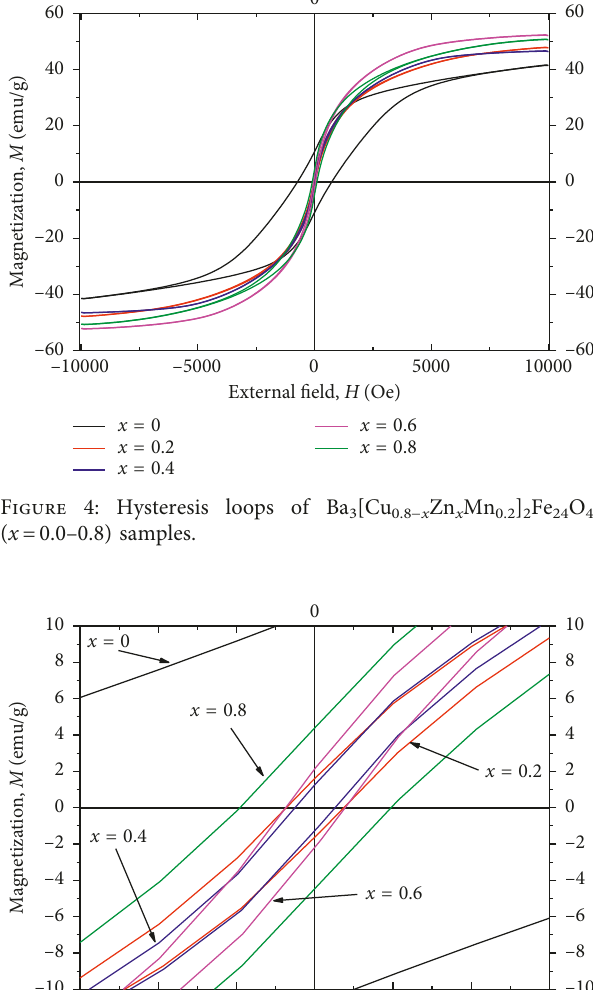
Figure 5: Expanded view of the hysteresis loops of